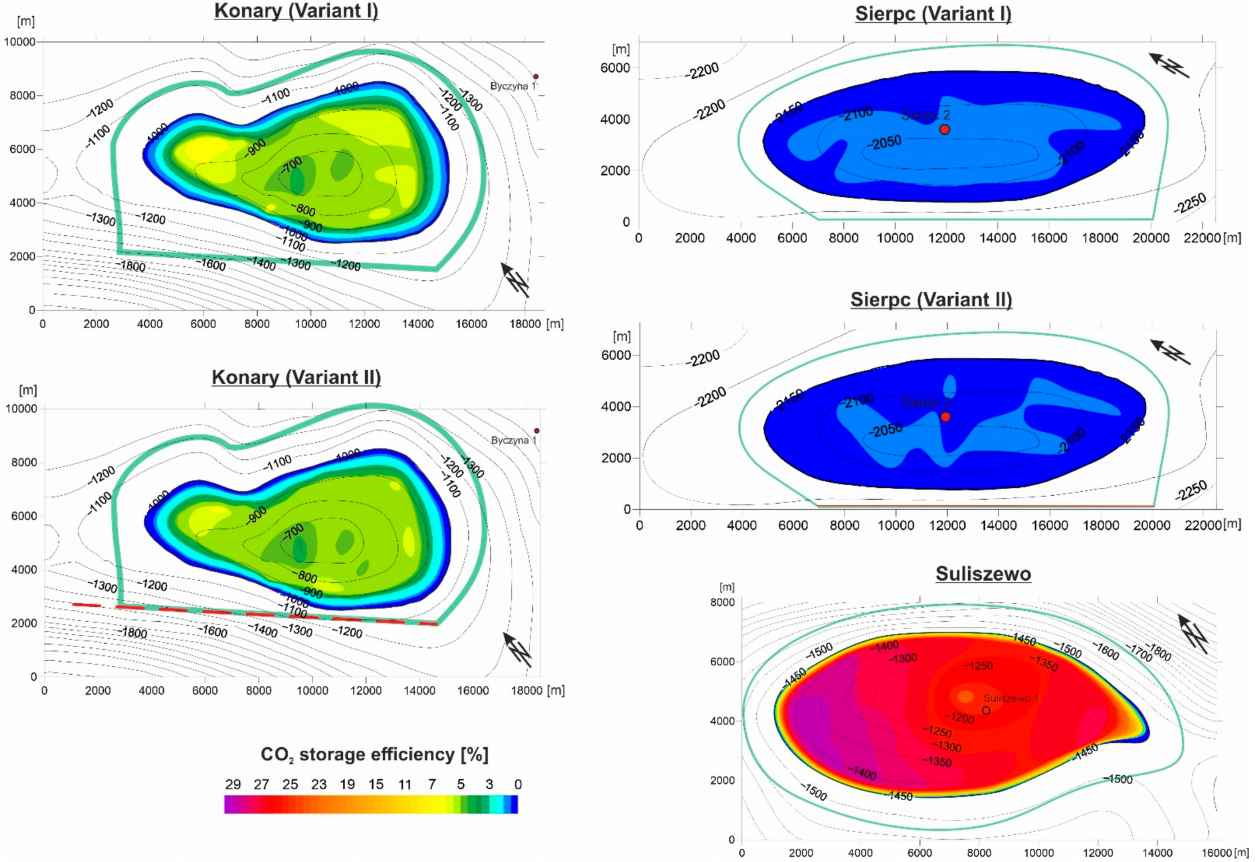
Figure 6. Maps of the CO 2 storage efficiency in the Konary, Sierpc, and Suliszewo structures as a function of injection well